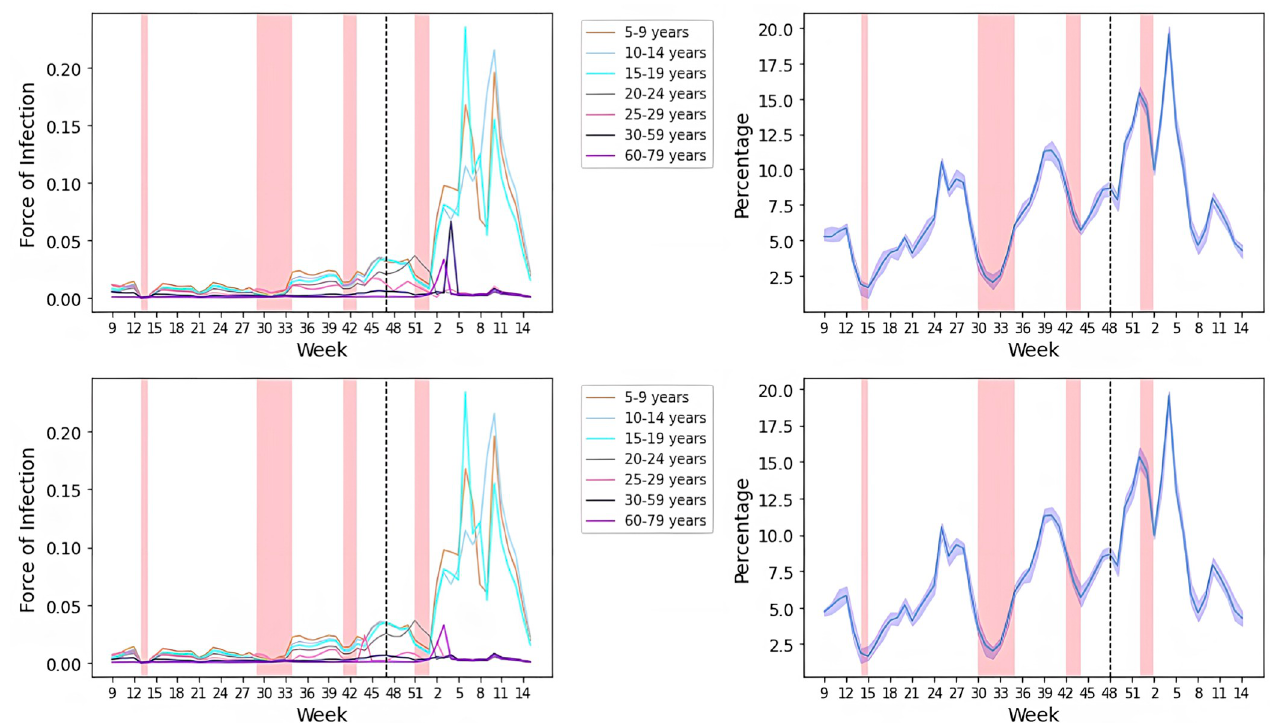
Fig 6. Estimated force of infection and contribution of contacts of infected persons in school to overall transmission in Germany week 9/2021 to 15/2022, accounting (c and d) and not accounting for underdetection (a and b). Pink areas represent periods when the majority (at least 7) federal states have school vacations. Vacation periods in federal states in Germany differ by multiple weeks and will span periods prior and post to the areas marked. W16-21 include county-specific incidence-dependent school closures which affected less than 50% of counties in Germany. The dotted line represents the onset of predominance of the delta variant among cases in Germany. Age-specific underestimation parameters were continued as for the delta variant, as no estimates for age-specific underdetection of the omicron variant were available at the time of publishing.